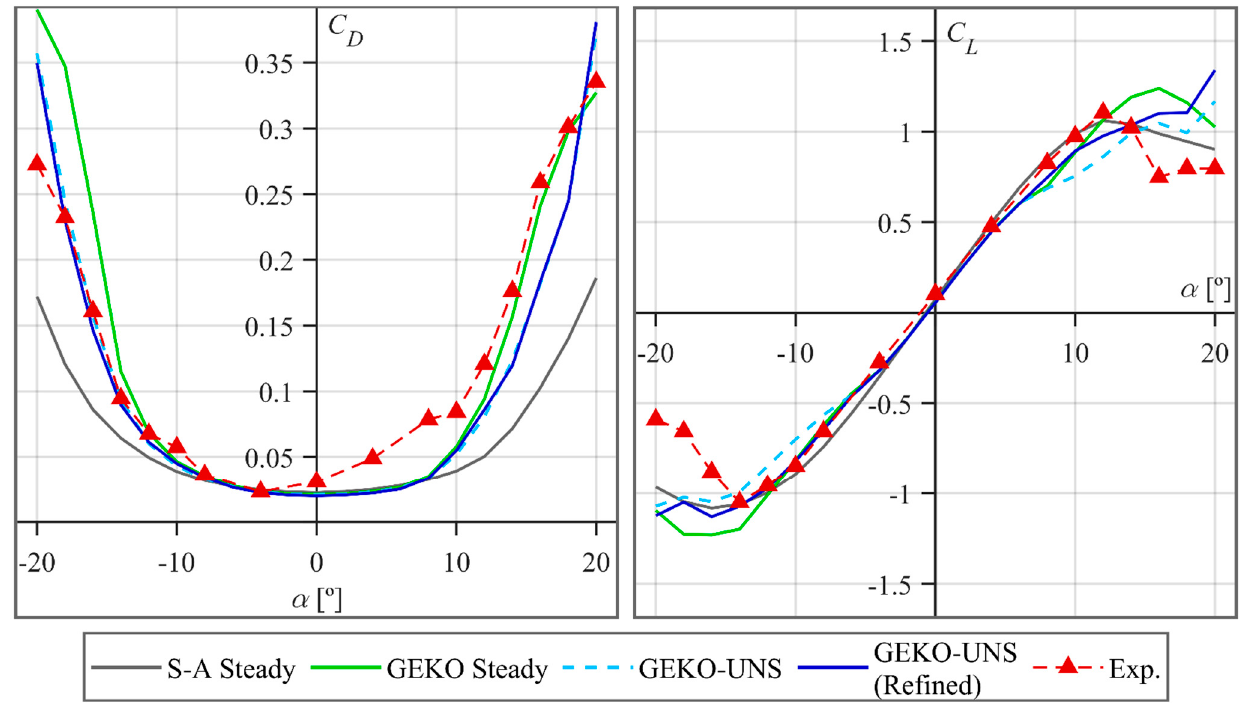
Figure 7. Experimental drag and lift coefficients from airfoil DU06-W-200 compared with results from CFD simulations for different turbulence models.